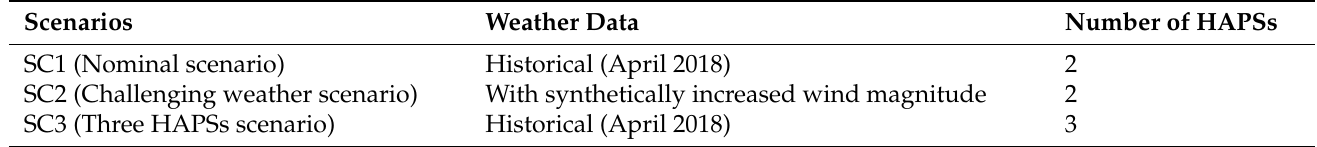
Table 2. Scenarios considered for performance